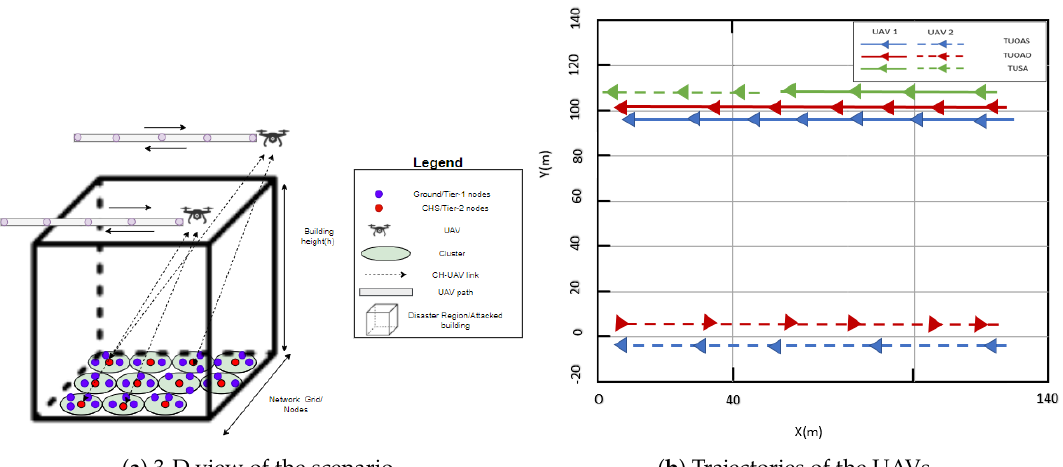
Figure 16. Trajectories of UAVs around the disaster